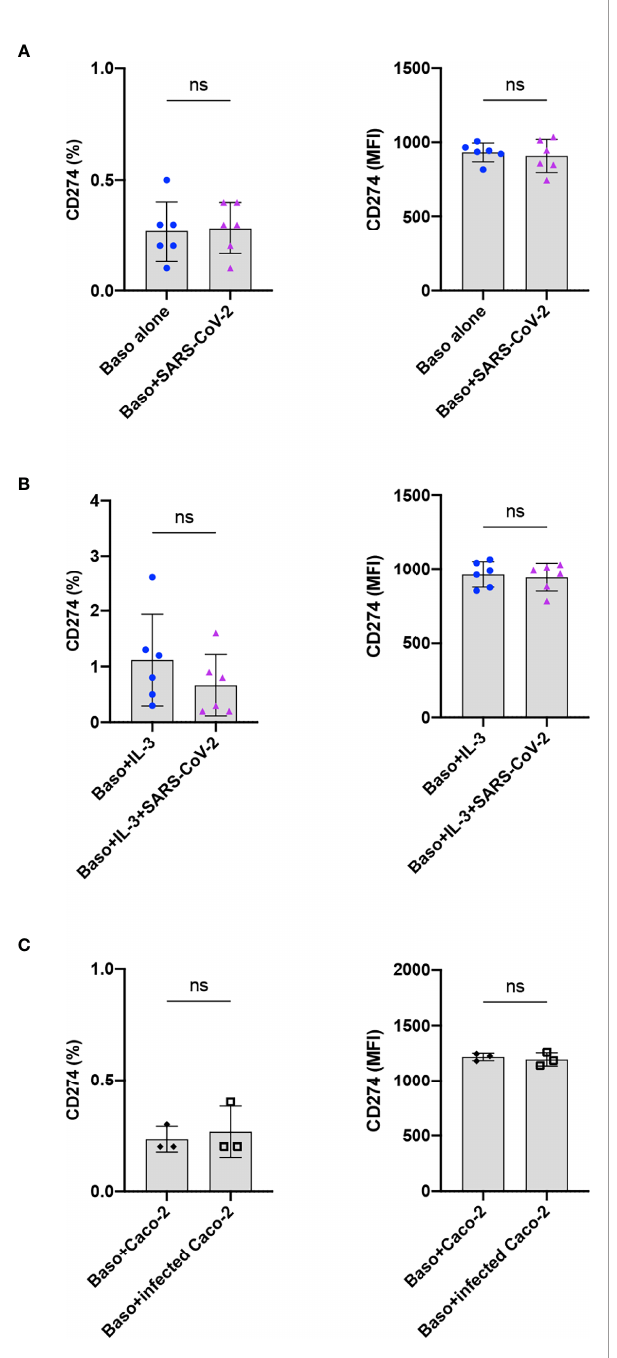
FIGURE 4 | SARS-CoV-2 does not induce PD-L1 on the basophils. The expression of PD-L1 on the basophils under various experimental conditions of SARS-CoV-2 stimulation. (A) Resting basophils (0.1x10 6 cells/100 µl) were cultured with or without SARS-CoV-2 for 24 h and the expression of PD-L1 was analyzed by fl ow cytometry. (B) Basophils were primed with IL-3 along with infection with SARS- CoV-2. Non-infected basophils were used as a control. PD-L1 was analyzed after 24 h culture. (C) Basophils were cultured with either non-infected or SARS-CoV-2 infected Caco-2 cells for 24 h. The data (mean ± SD) were presented as % cells positive for PD-L1 and median fl uorescence intensities (MFI), and were from 3 (C) to 6 (A, B) independent donors. ns, not signi fi cant, paired Wilcoxon